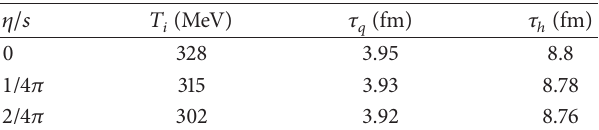
Table 2: The values of various 𝜂/𝑠 and parameters—initial tempera- ture( 𝑇 𝑖 ),startingtimeofmixedphase( 𝜏 𝑞 ),andendingtimeofmixed phase ( 𝜏 ℎ )—used in the present